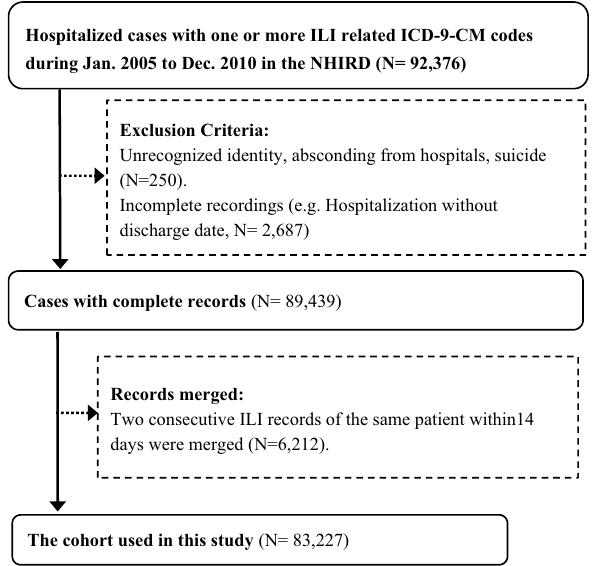
Figure 1. Flow diagram of the selection process of study subjects. ICD-9-CM International Classification of Diseases, 9th Revision, Clinical Modification, ILI influenza-like illness, NHIRD National Health Insurance Research